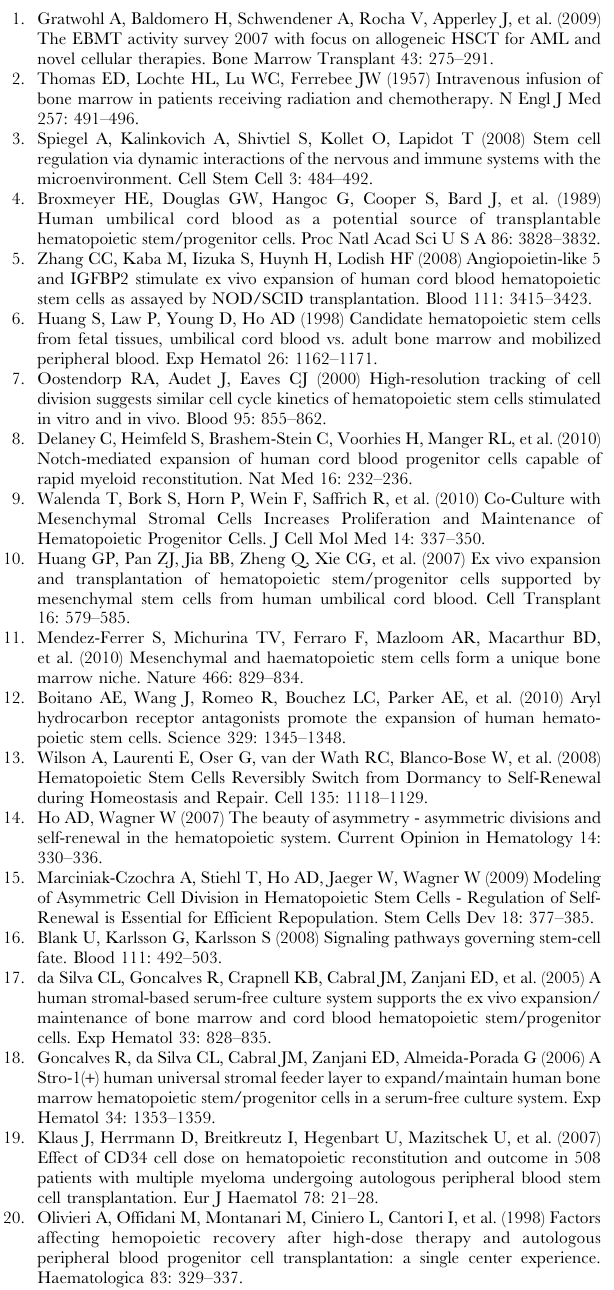
Figure S4 Effects of MCP-1 on in vitro expansion of HPC. CD34 + cells were stained with CFSE and cultured for seven days in culture medium either with 10% patient serum (BC; A) or with TPO, FGF and SCF (B). Addition of different concentrations of MCP-1 did not affect proliferation or CD34 expression of HPC.